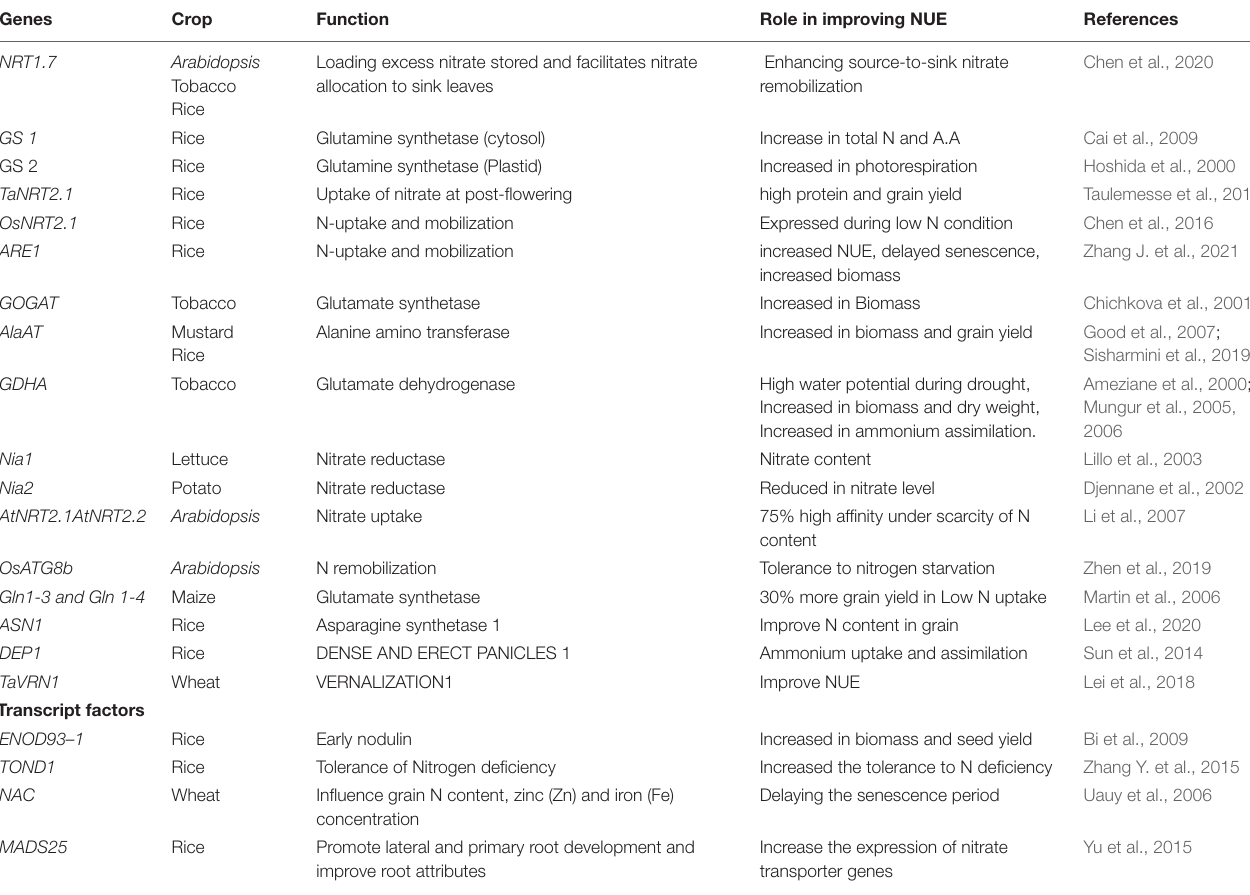
TABLE 4 | Transgenes introduced and their role in improving nitrogen use efficiency. Genes